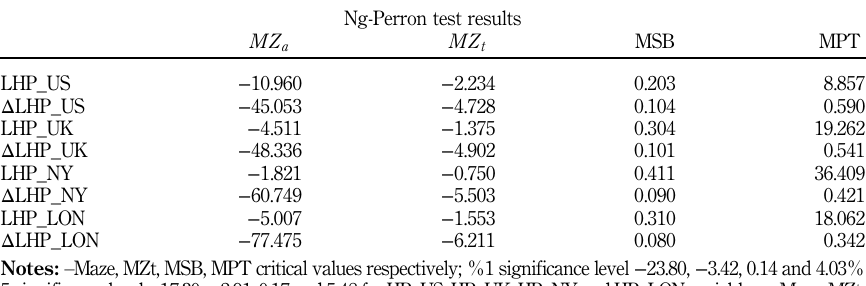
Table I. Unit root test results